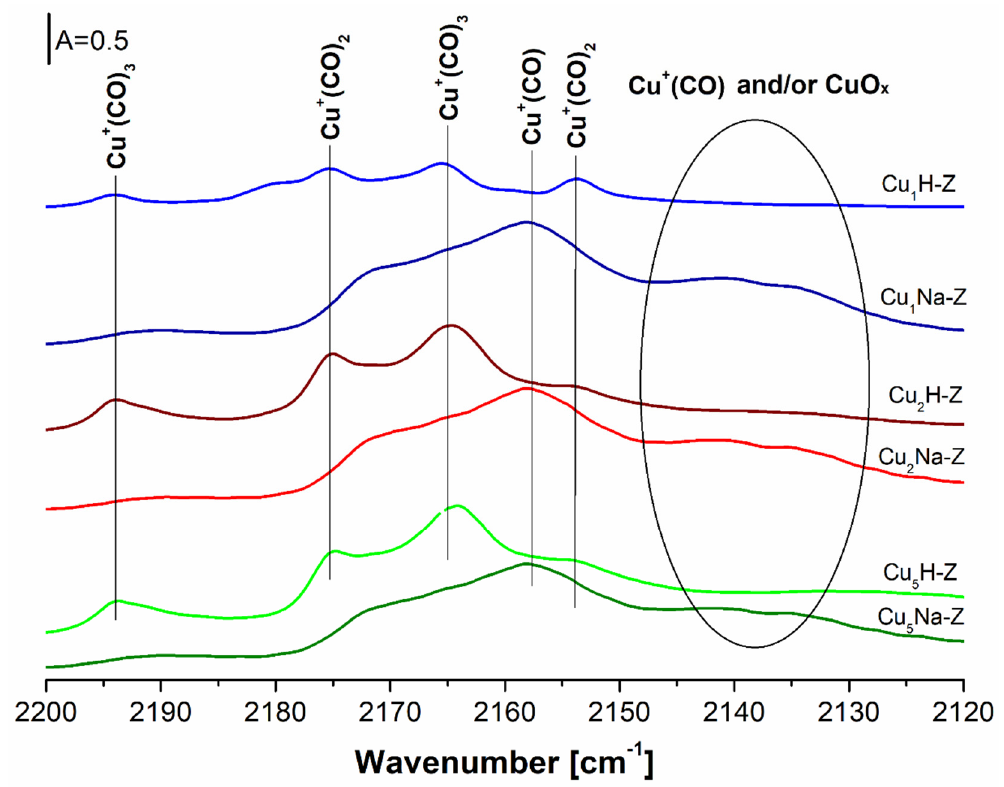
Figure 8. IR spectra of CO adsorbed at − 100 ◦ C on the surface of Cu-zeolite samples. For the samples additionally pretreated with NaNO 3 (Cu x Na-Z), the bands at 2158, 2135 and 2140 cm − 1 were registered (Figure 8). While the band at 2158 cm − 1 was assigned to Cu + (CO), the interpretation of the bands at 2135 and at 2140 cm − 1 was not straightfor- ward. They may be assigned to another kind of copper site [66] or to the associated Cu ions [67]. Datka et al. [62] evidenced simultaneous occurrence of species by the presence of the bands at 2158 and 2135 cm − 1 which allowed us to suppose that the adsorption of CO was not an equilibrium process at low temperature ( − 100 ◦ C). CO interacted with copper by adsorbing on all accessible sites. Subsequently, the redistribution took place: CO desorbed from sites of lower adsorption heat and re-adsorbed on sites having higher binding energy. Due to the low rate of desorption at − 100 ◦ C (requiring CO molecules to overcome